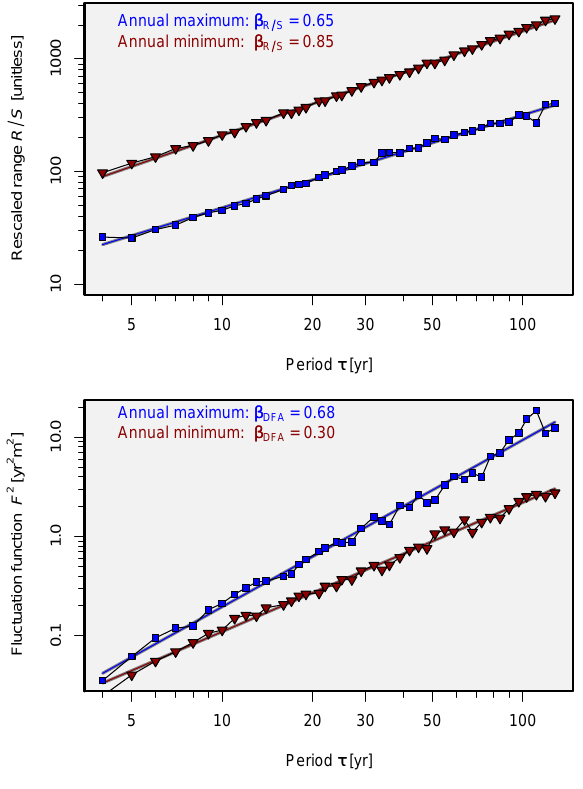
Fig. 7. LRD property estimates for Nile River time series in the 622–1900 AD interval. (a) Rescaled-range (R/S) analysis; and (b) detrended fluctuation analysis (DFA). Results for annual minimum water levels (red triangles; see also Fig. 2) and maximum levels (blue squares). Straight, blue and red lines are the best-fit power-law functions for window widths of 4yr ≤ τ ≤ 128yr. The estimated correlation strength values of β R/S and β DFA are given in the figure legend; the color of the estimates matches that of the corresponding line.